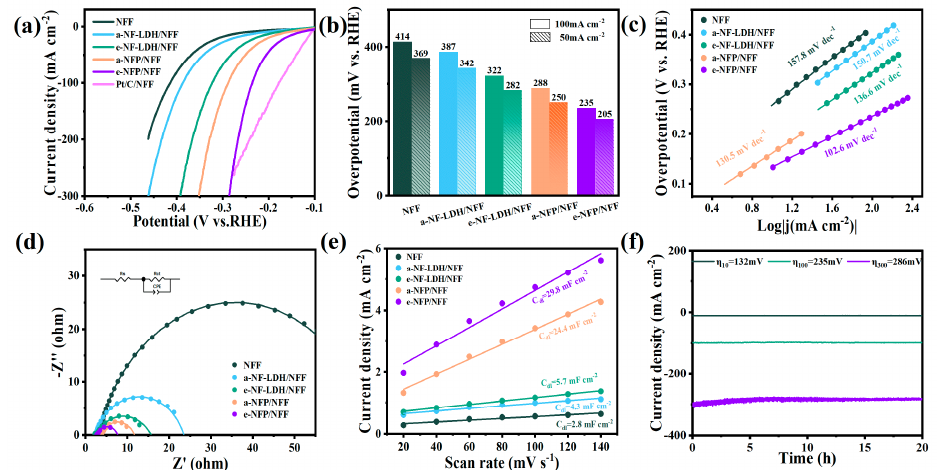
Figure 6. ( a ) HER polarization curves with iR − compensation for Pt/C/NFF, NFF, a − NF − LDH/NFF, e − NF − LDH/NFF, a − NFP/NFF and e − NFP/NFF; ( b ) overpotentials at 50 and 100 mA·cm − 2 ; ( c ) Tafel plots of the corresponding samples; ( d ) Nyquist plots; ( e ) C dl of the corresponding samples; ( f ) time − dependent current density curve of e − NFP/NFF at overpotentials of 132, 235, and 286 mV. To better estimate the reaction dynamics of HER, the Tafel plot derived from the of e-NFP/NFF is 102.6 mV·dec − 1 , which is significantly lower than that of a-NFP/NFF (130.5 mV·dec − 1 ), e-NF-LDH/NFF (136.6 mV·dec − 1 ), a-NF-LDH/NFF (150.7 mV·dec − 1 ), and